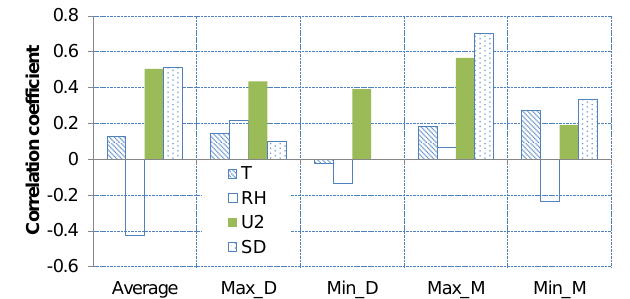
Figure 2. The correlation coefficients between ET 0 and meteo- rological variables of T , RH, U 2 and SD (average: annual av- erage; Max_D and Min_D: the maximum and minimum among 365/366 daily values per year; Max_M and Min_M: the maximum and minimum among 12 monthly values per